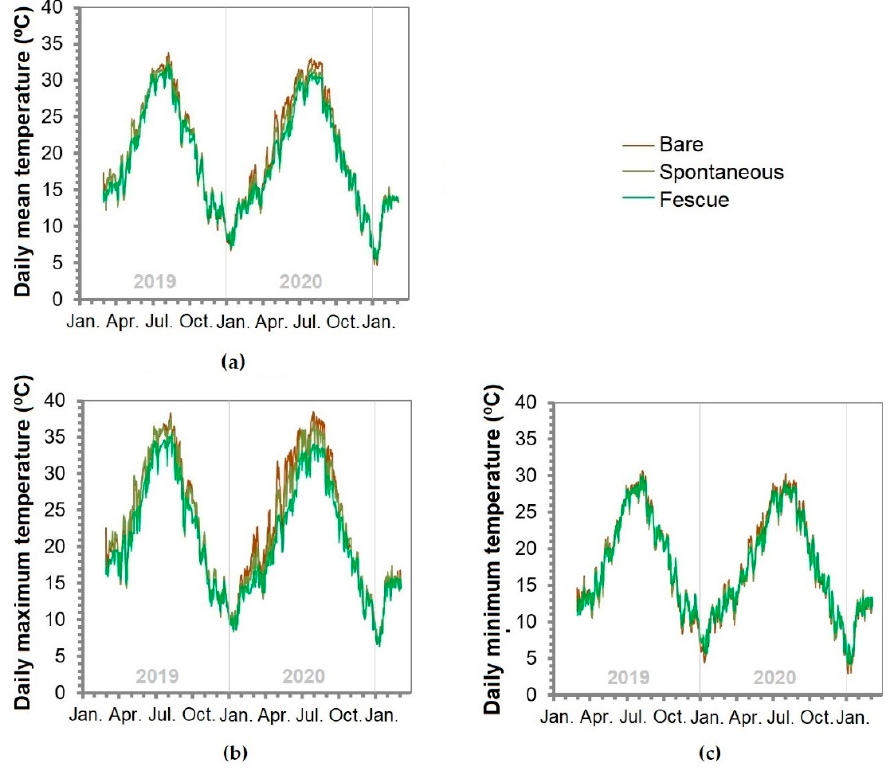
Figure 2. ( a ) Daily mean temperature at 5–10 cm depth in the different treatments; ( b ) daily maximum temperature; ( c ) daily minimum temperature.